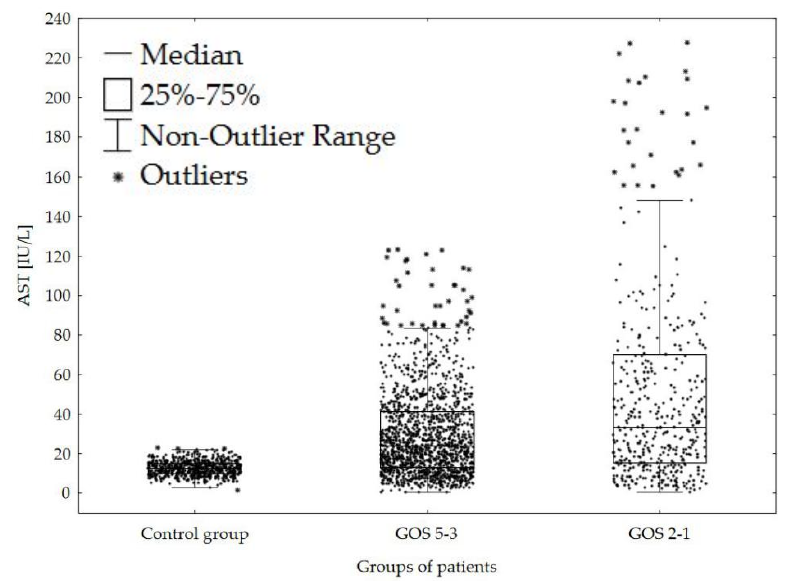
Figure 1. Comparison of AST catalytic activities in the CSF (cerebrospinal fluid) of patients following CNS (central nervous system) haemorrhage with a GOS 5–3 and GOS 2–1. Legend: Control group = 640 patients without injury of the CNS; GOS = Glasgow outcome scale; AST = catalytic activity of aspartate aminotransferase in the CSF. Table 1. Development of estimated means of AST catalytic activities in the CSF of patients following CNS haemorrhage with a GOS 5–3 and a GOS